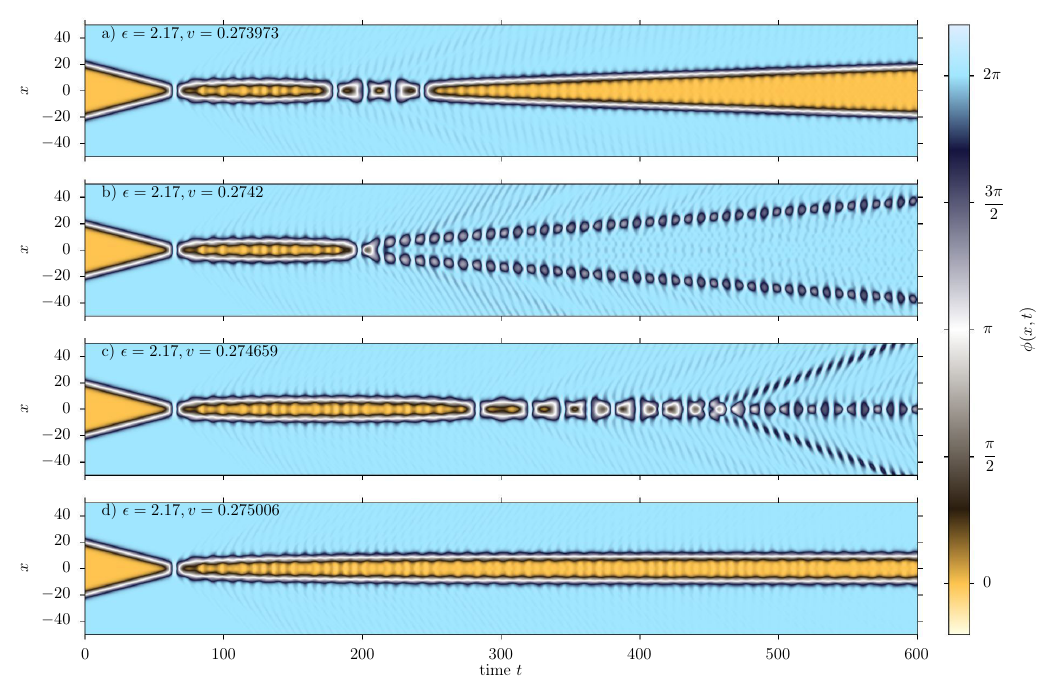
Figure 19 . Spacetime plots of the four collisions of figure 18. The second plot shows the emission of a pair of bions at t ≈ 200 , which rapidly transport energy away from the central region. The centrally-located bion in the third plot emits a burst of radiation at t ≈ 460 ; this is an example of the staccato radiation phenomenon discovered in [28].